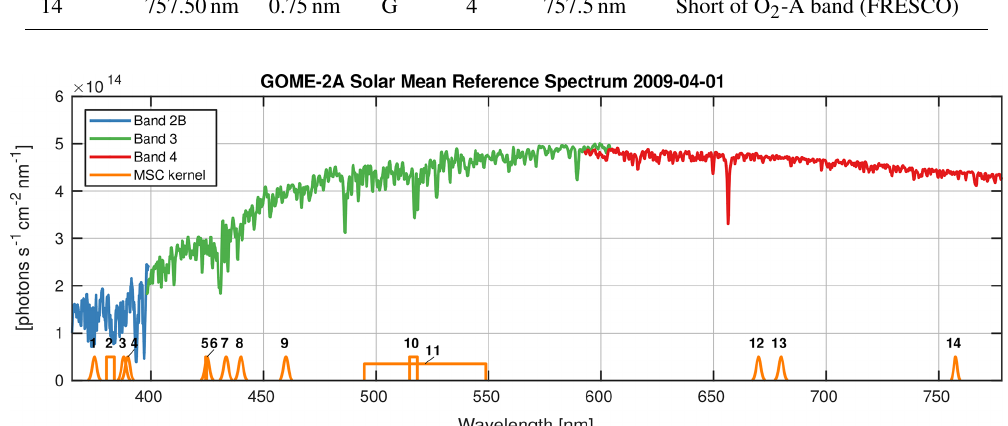
Figure 2. Mean solar spectrum of GOME-2A MSC channel 2B, 3, and 4 recorded on 1 April 2009. Spectral convolution kernels K k from Table 1 are plotted in orange. Note the small biases between overlapping bands due to different calibrations.